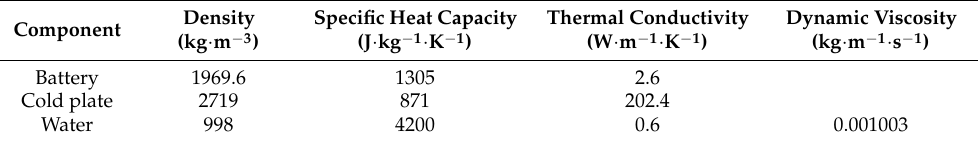
Table 2. Parameter values for the flow channels within the cold plate. Case